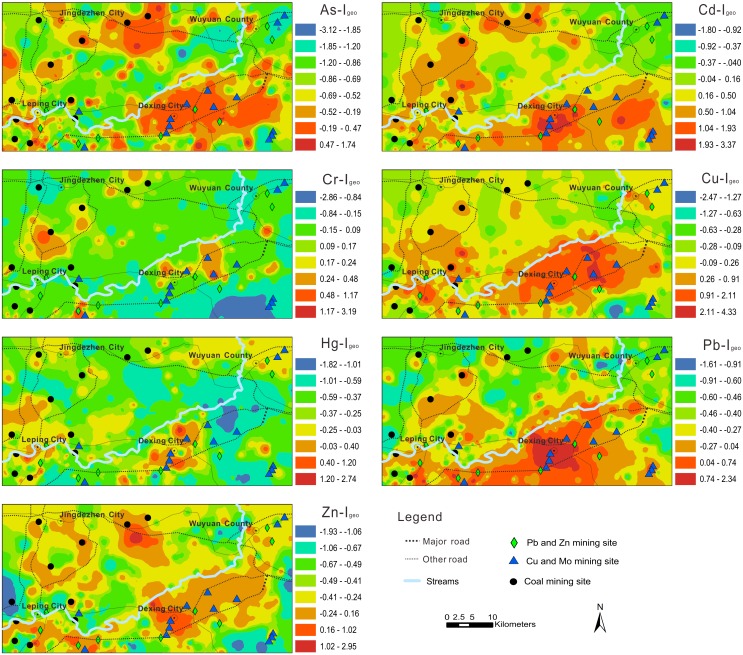
Spatial distribution of Igeo of trace elements in soil of the study area.